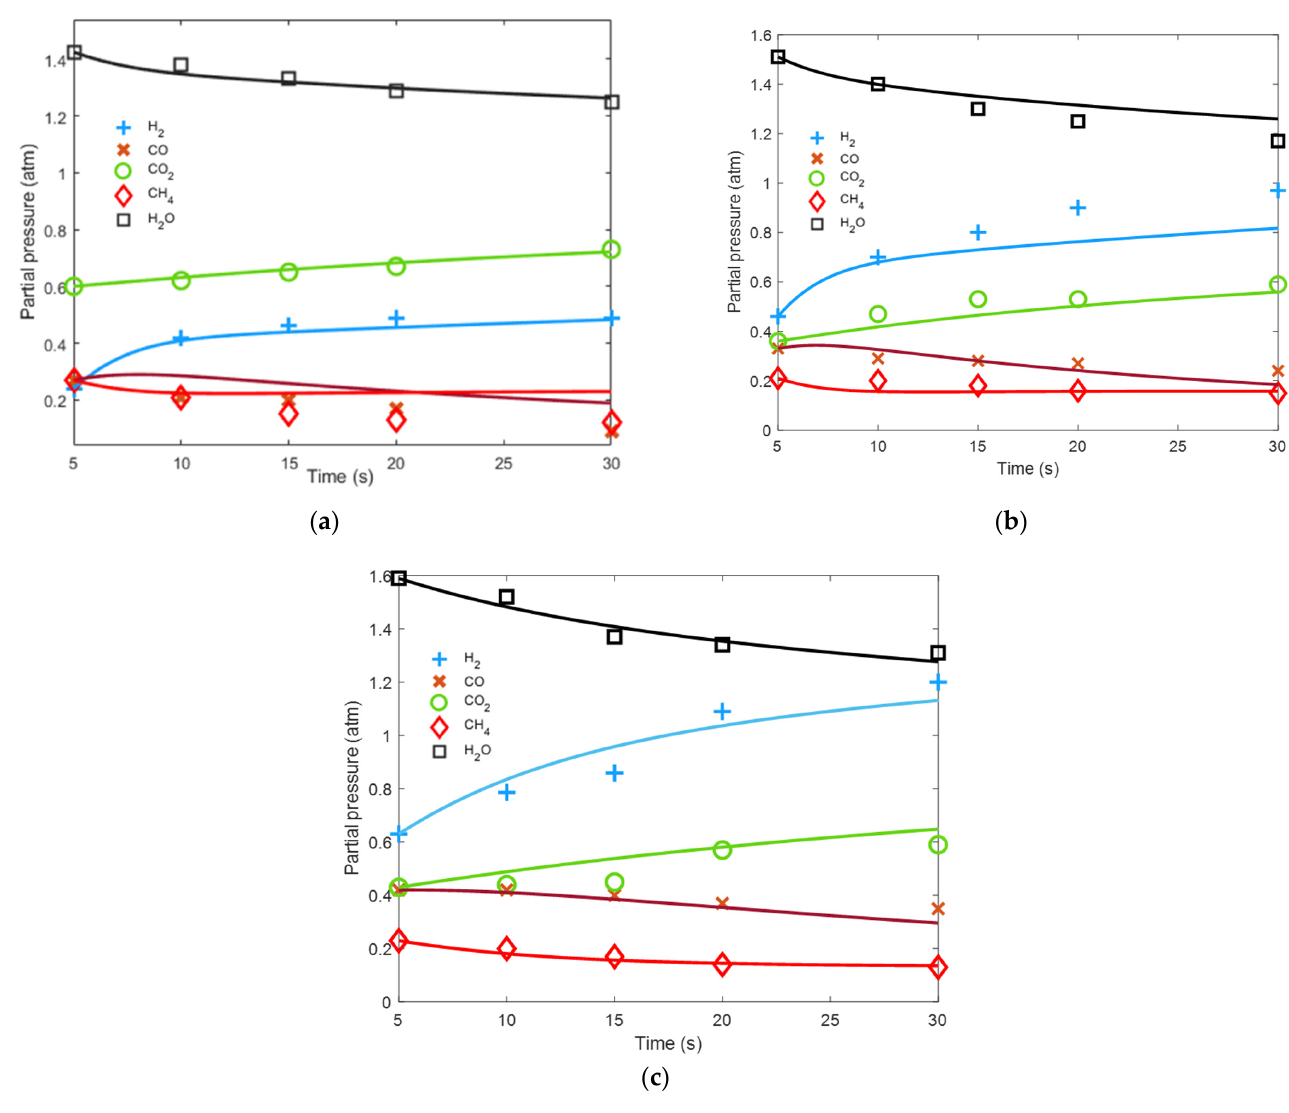
Figure 4. Model fitting to experimental partial pressures of H 2 , CO, CO 2 , CH 4 and H 2 O during steam gasification of 2-methoxy-4-methyl phenol with the catalyst 5% Ni–0.25% Ru/ γ Al 2 O 3 (Cat B) with S/2M4MP = 1 g/g and Cat/2M4MP = 2.63, R 2 = 0.9931. ( a ) 550 °C, ( b ) 600 °C y ( c ) 650 °C. The four estimated intrinsic parameters (cid:3435)k (cid:2907)(cid:2891)(cid:2903)° , k